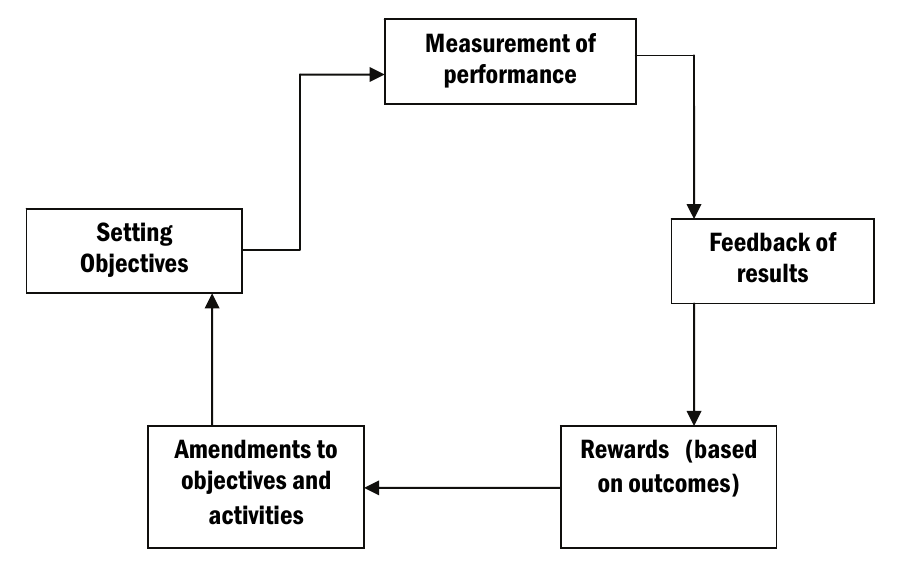
Figure 1: The Performance Management